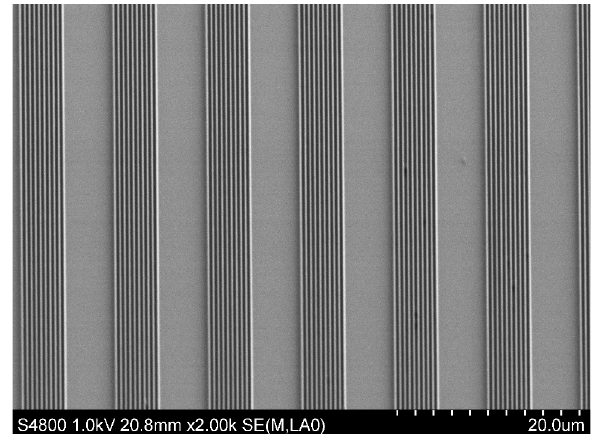
Figure 2. SEM image of the grating in silicon